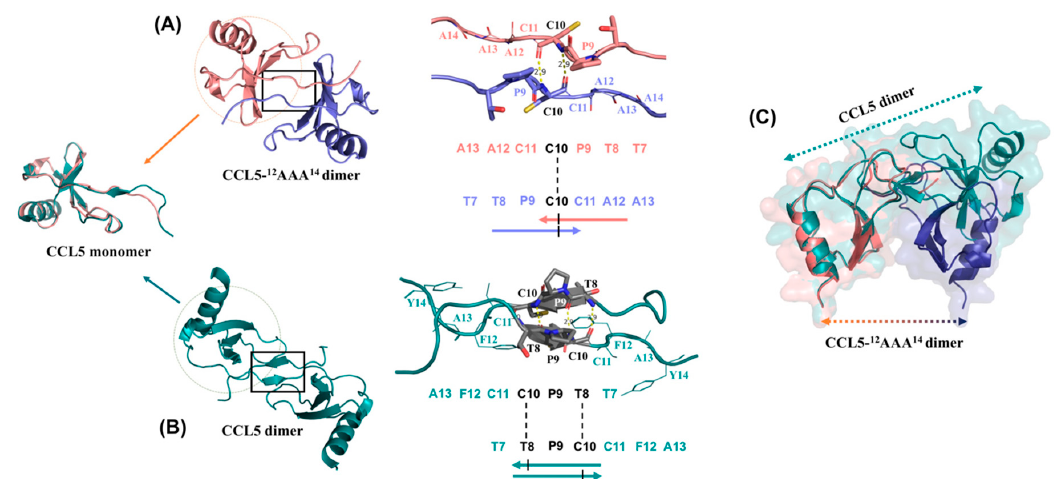
Figure 4. Structural comparison between the CCL5 dimer (PDB code 1EQT) and the CCL5- 12 AAA 14 dimer. The two dimers share the same monomer structure. The shifts in the N-terminal backbone pairing causes the structural differences. ( A ) The structure of the CCL5- 12 AAA 14 dimer with a detailed interaction at the dimer interface, centered at residue C10. ( B ) The structure of the CCL5 dimer with a detailed interaction at the dimer interface, centered at the 8 TPC 10 sequence. ( C ) The orientation difference between the CCL5- 12 AAA 14 dimer and the native CCL5 dimer. One of the monomer units of CCL5- 12 AAA 14 dimer overlaps with the monomer unit of the CCL5 dimer for comparison.